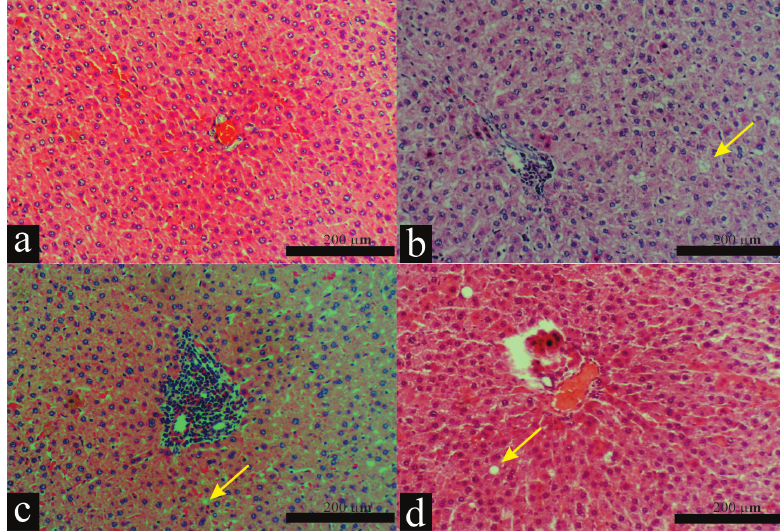
Figure 3 - Effect of exposure to CAF diet pre and post weaning, alone or in combination, on histological aspects of the liver of male adult F1 offspring at 100 d of age. Representative image of livers with H&E staining (200X magnification); a-d ; Scale bars: 150 μm. Qualitative histological analyses evaluated the profile of lipid infiltration in the hepatocyte cytosol. The degree of steatosis was evaluated according to Brunt (2001) (Table II). Lipid droplets are indicated by yellow arrows. The number of animals analyzed was 5-7 rats per group from five different litters.